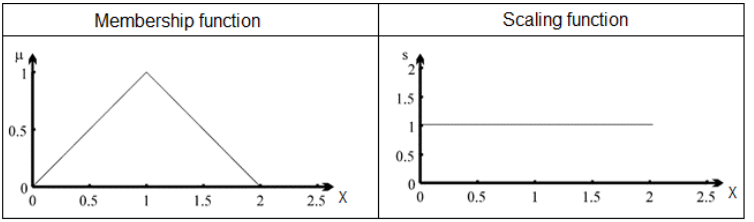
Figure 3. Fuzzy membership function ( left ) and scaling function ( right ).